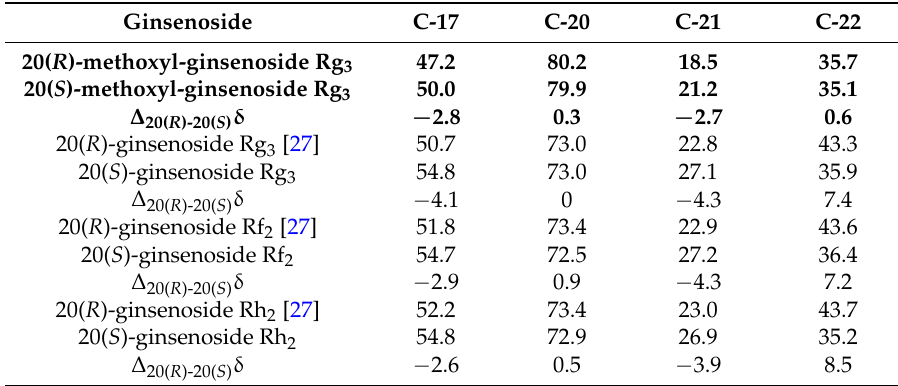
Table 2. Chemical shift differences of C-17, C-20, C-21, and C-22 between 20( R ) and 20( S ) isomer ginsenosides (in C 5 D 5